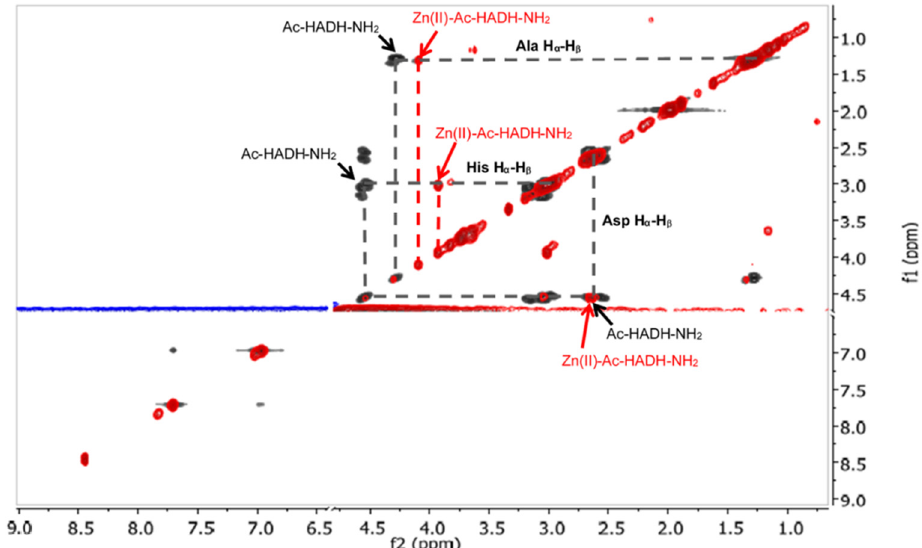
Figure 14. 1 H − 1 H TOCSY spectra of the Zn(II)-Ac-HADH-NH 2 system (red) compared to the free Ac-HADH-NH 2 ligand (black) (pH~8.2). The presence of the zinc(II) ion causes different chemical shifts of two histidyl and alanyl methine protons. The marked cross peaks are derived from the correlation between the H β and H α protons.